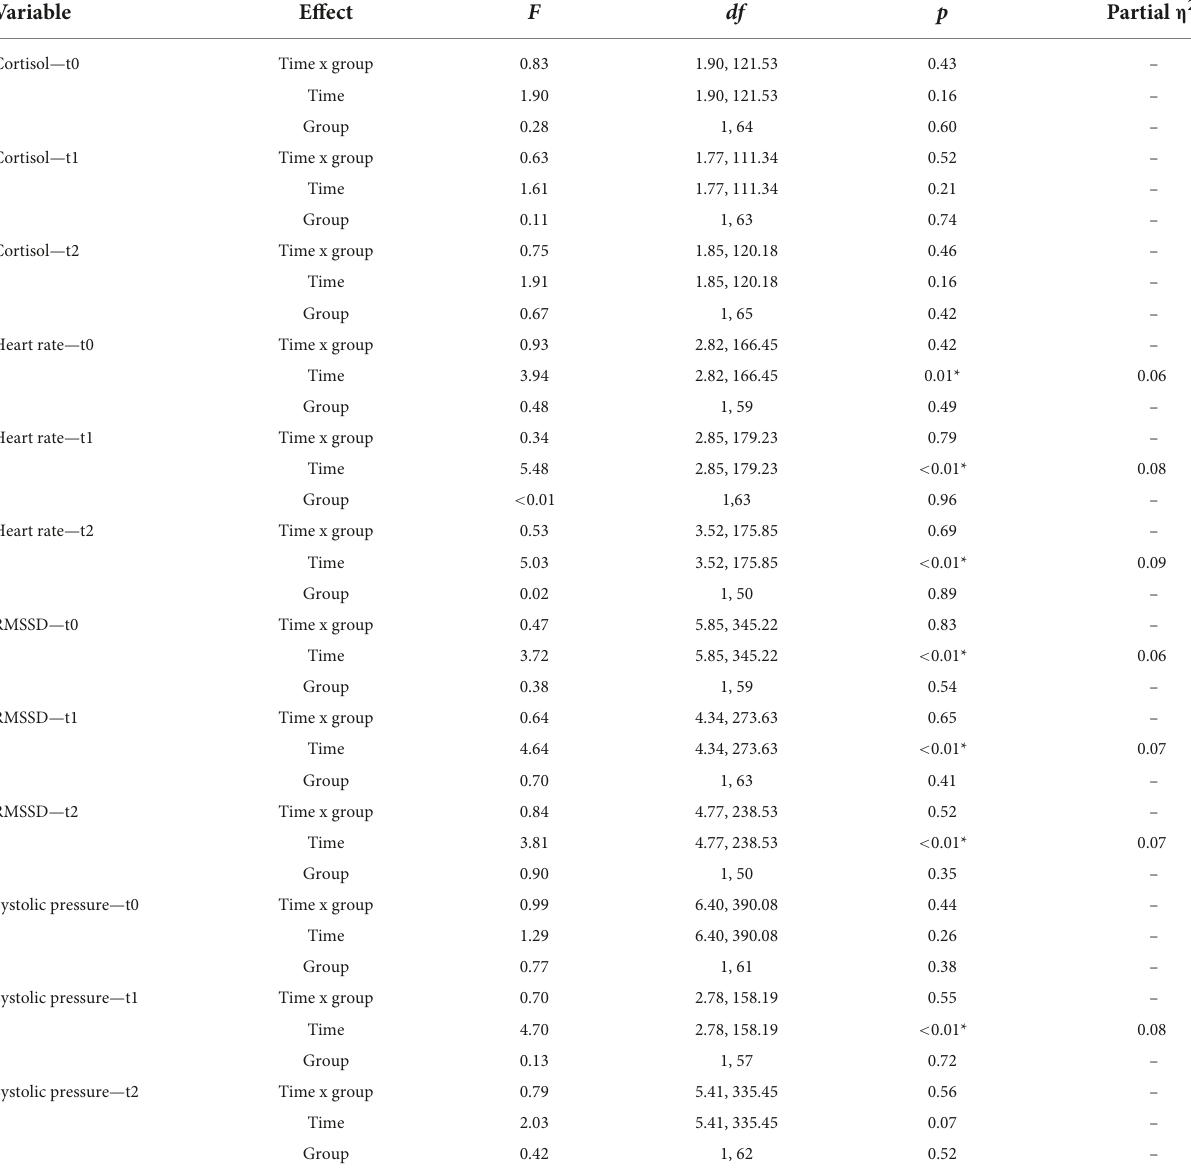
TABLE 2 Results for the group x time interaction effects (mixed ANOVA) in men within Trier Social Stress Test for groups (TSST-Gs). Variable